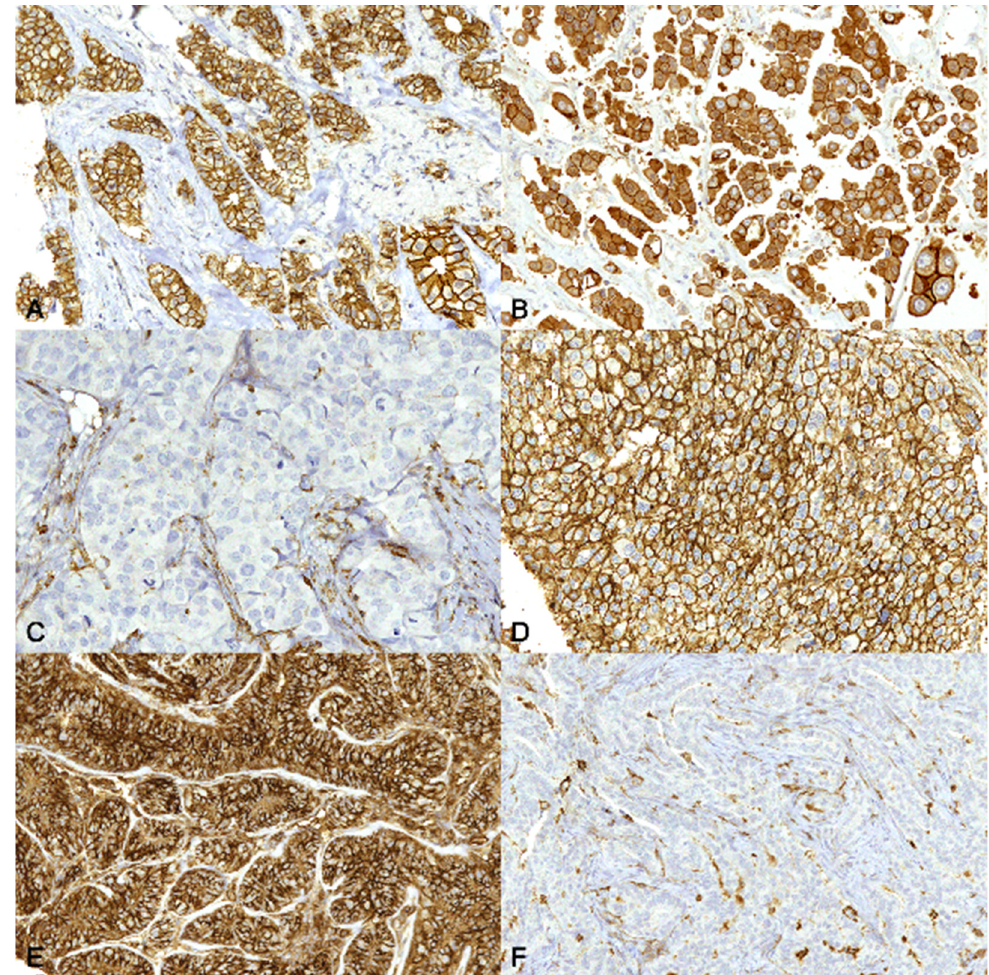
Figure 5. Carcinoma, mammary gland. Immunohistochemistry for E-cadherin ( A , B ) and CD44 ( C